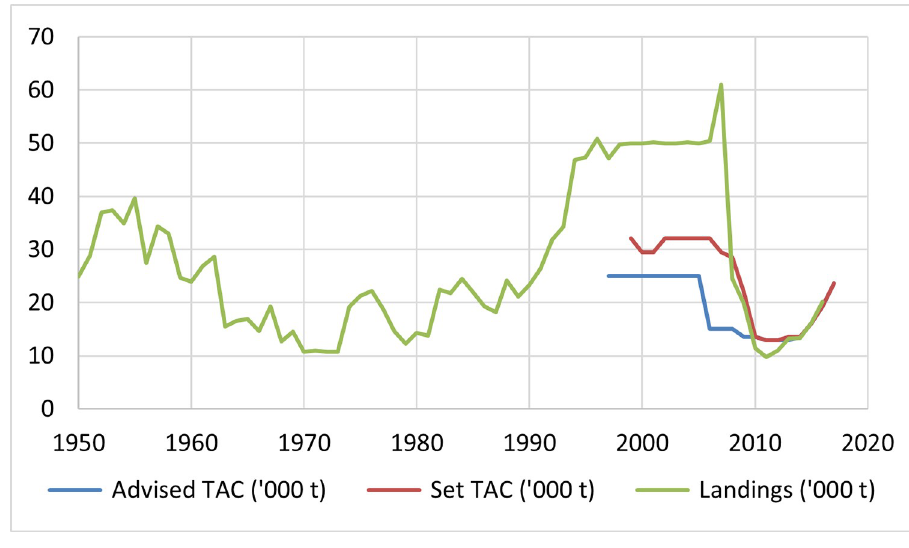
Fig 3. Advised TAC, set TAC and landings